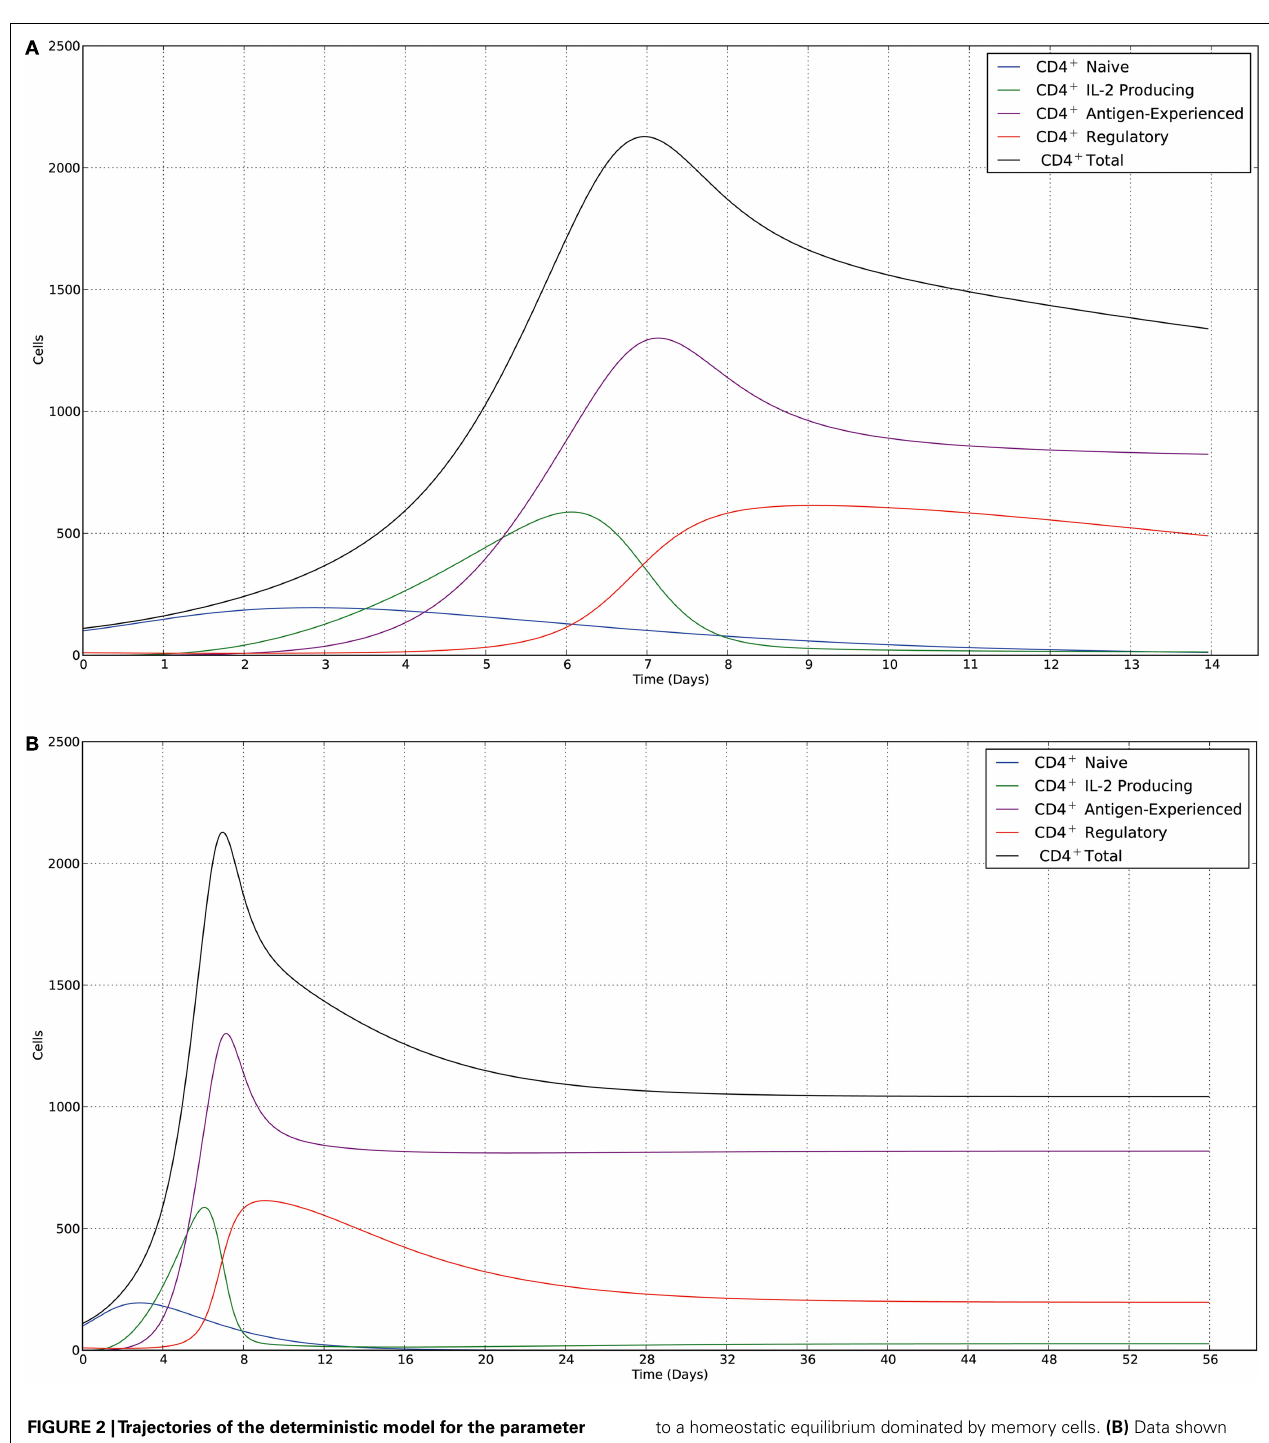
FIGURE 2 |Trajectories of the deterministic model for the parameter set given inTable 1, with the following initial conditions: 100 naïve cells (blue) and 10 regulatory cells (red). (A) Data shown over a time course of 2weeks.The immune response peaks at ∼ 7days, then declines